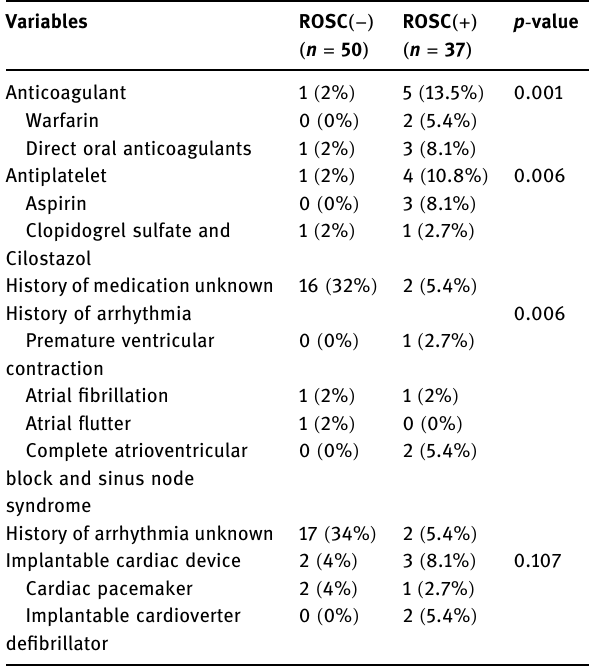
Table 2: History of the patients with OHCA